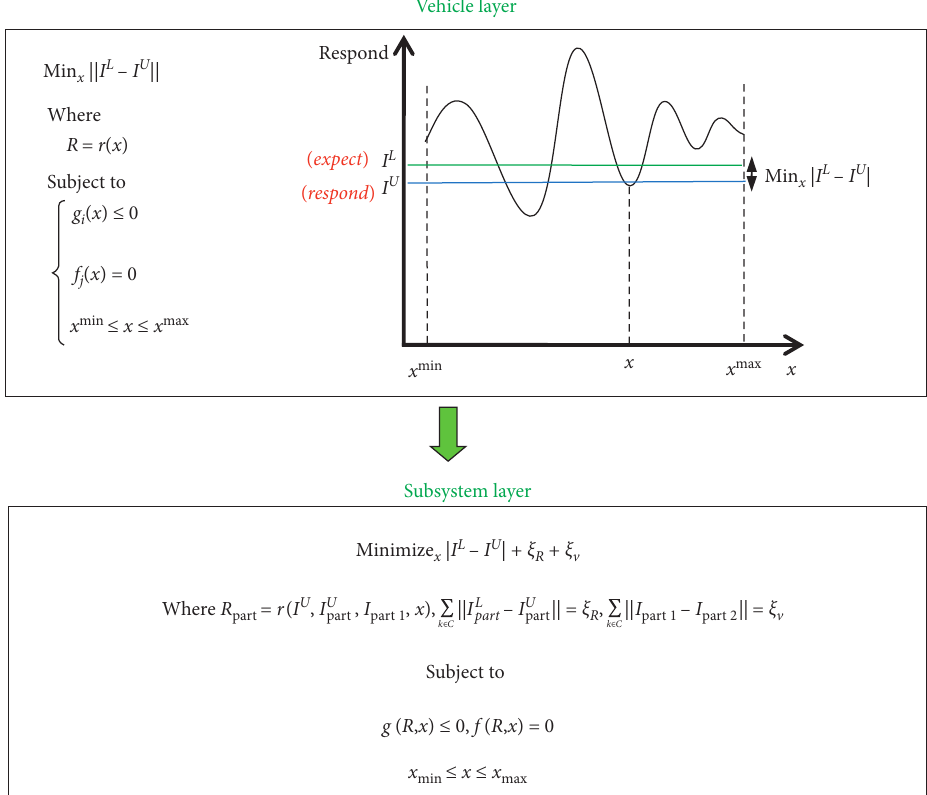
Figure 2: Interaction of parameter indexes between the vehicle level and subsystem